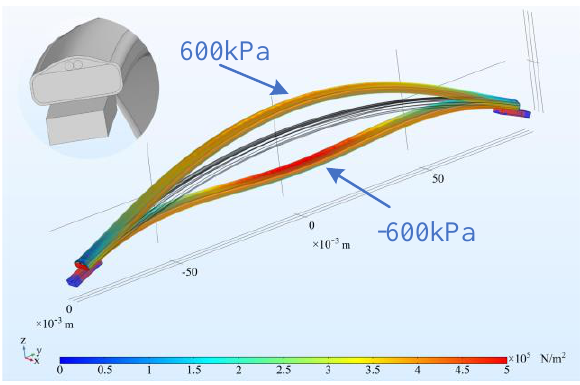
Figure 6. Strain transfer model and the deformation result.